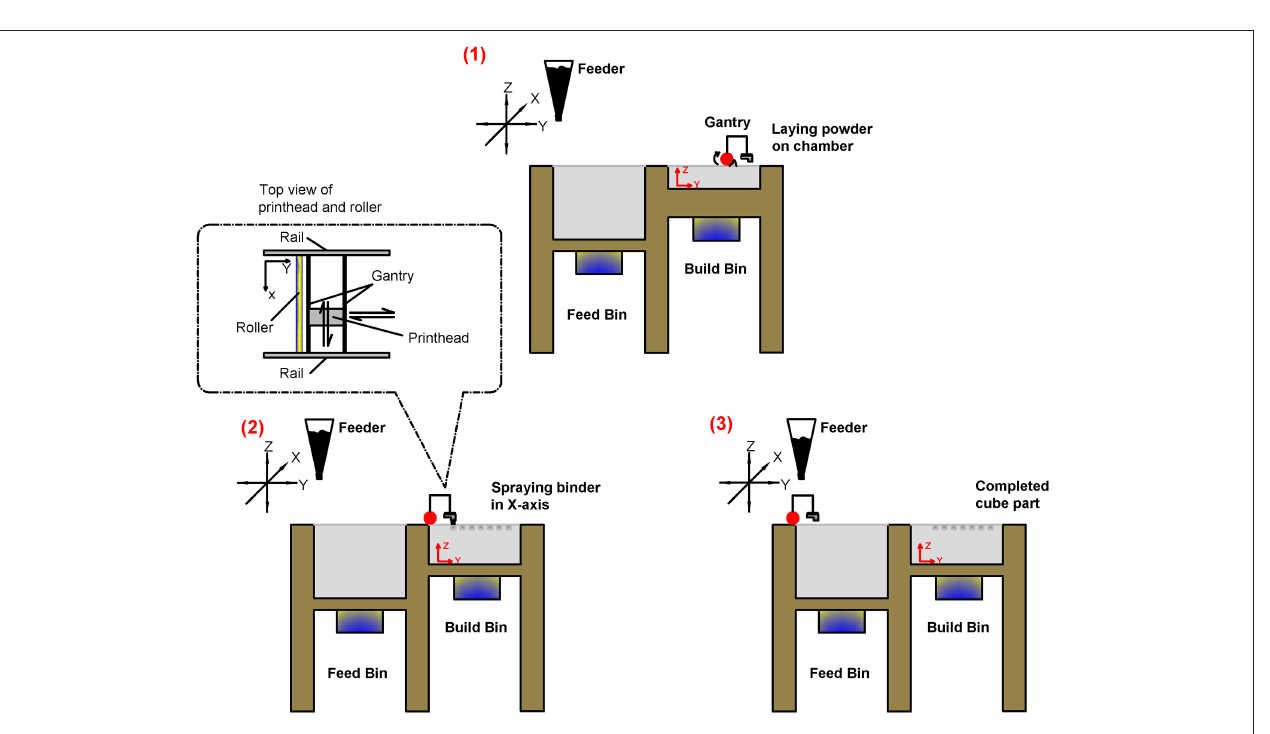
and Kurman (2013). Cañete Vela (2014) claimed that laser sintering can be used to make metallic and polymeric